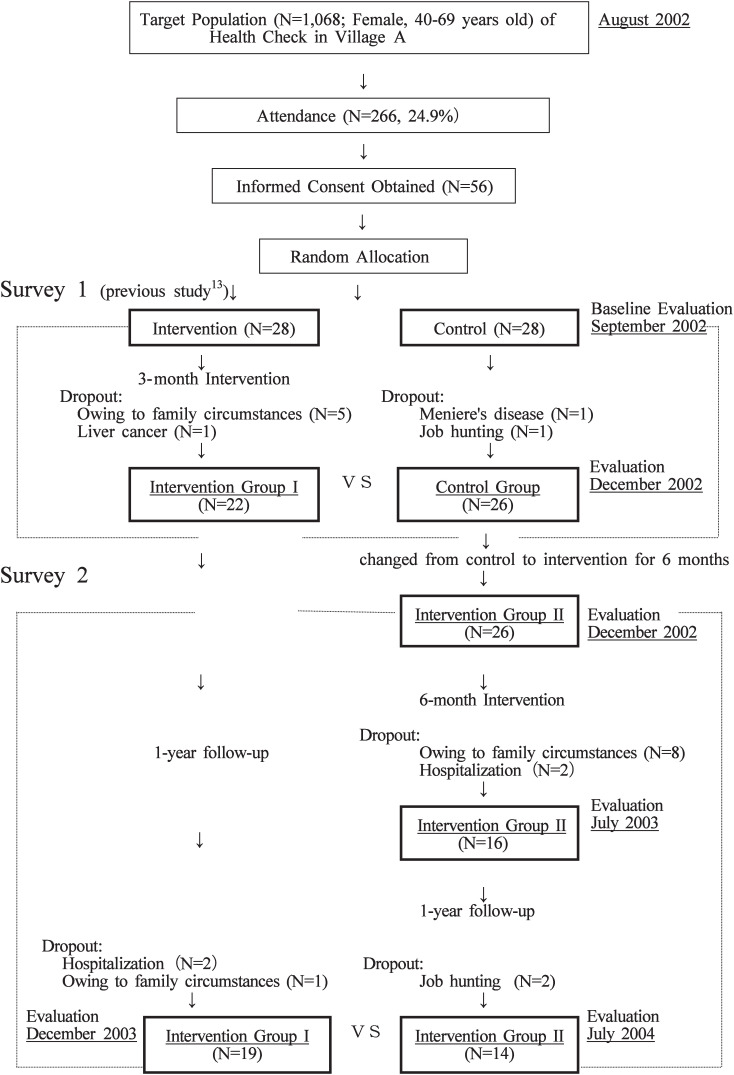
Subject recruitment and research process.